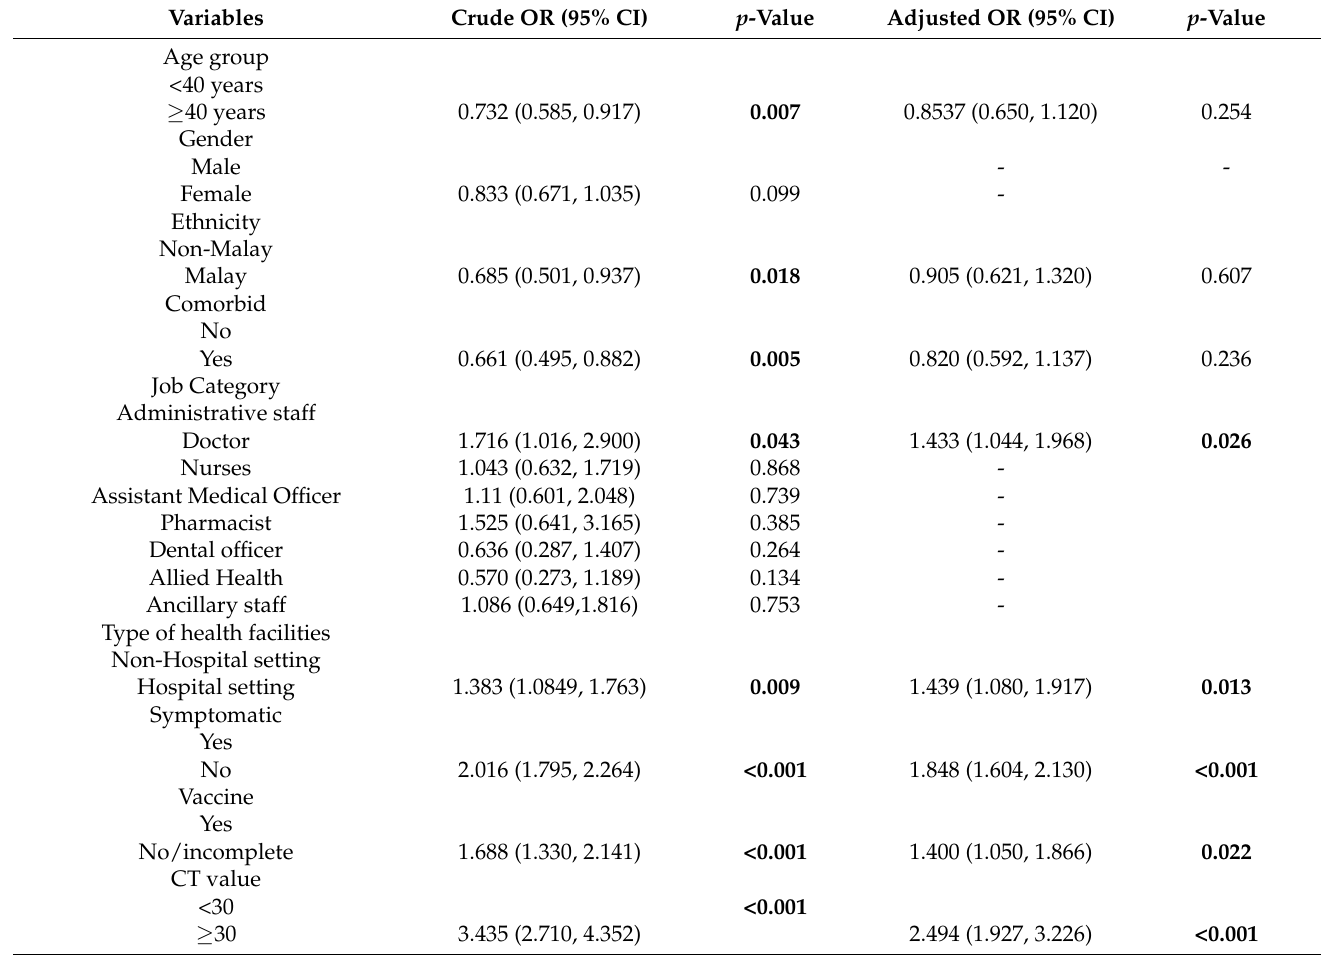
Table 2. Univariate and multivariate logistic regression on factors associated with healthcare- associated COVID-19 infection among HCWs in